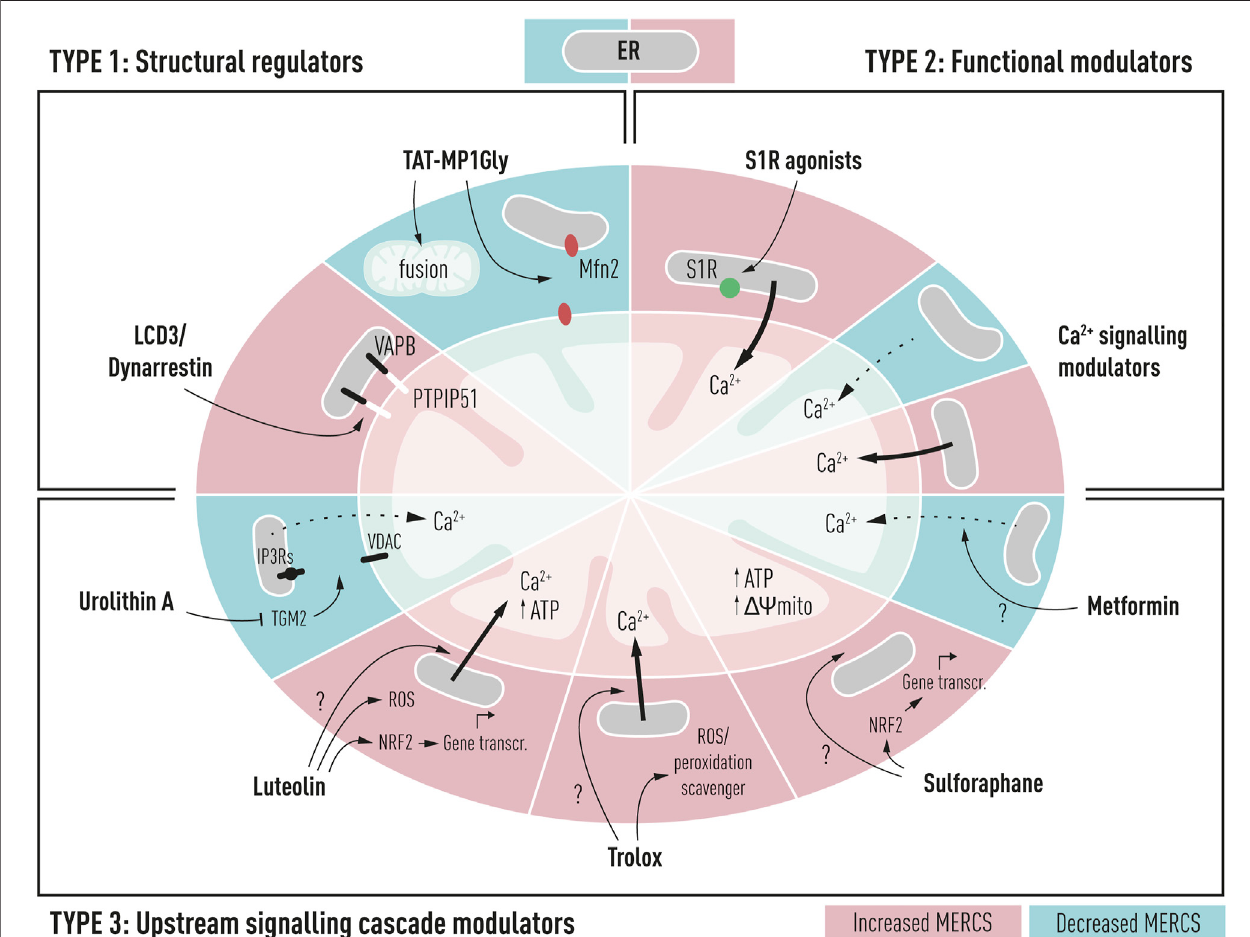
FIGURE 2 | Schematic representation of potential drug targets for the modulation of mitochondria – ER contacts in Alzheimer ’ s disease and their cellular and mitochondrial effects. TYPE 1: structural regulators such as LCD3/Dynarrestin and TAT-MP1Gly can interact directly with structural regulators of contacts such as PTPIP51 and Mfn2 resulting in increased or decreased proximity between the two membranes. TYPE 2: functional modulators could be used to alter the ER to mitochondria functional proximity, through modulation of Ca 2+ shuttling between the ER and mitochondria; such compounds include sigma-1 receptor agonists (S1R) and Ca 2+ signaling modulators targeting IP3Rs, VDAC, or MCU complex. TYPE 3: upstream signaling cascade modulators alter proximity between two membranes, but their speci fi c target is unknown. These compounds could affect upstream signaling cascades, leading to the alteration of MERCS proximity. These compounds include metformin, sulforaphane, Trolox, luteolin, and urolithin A.